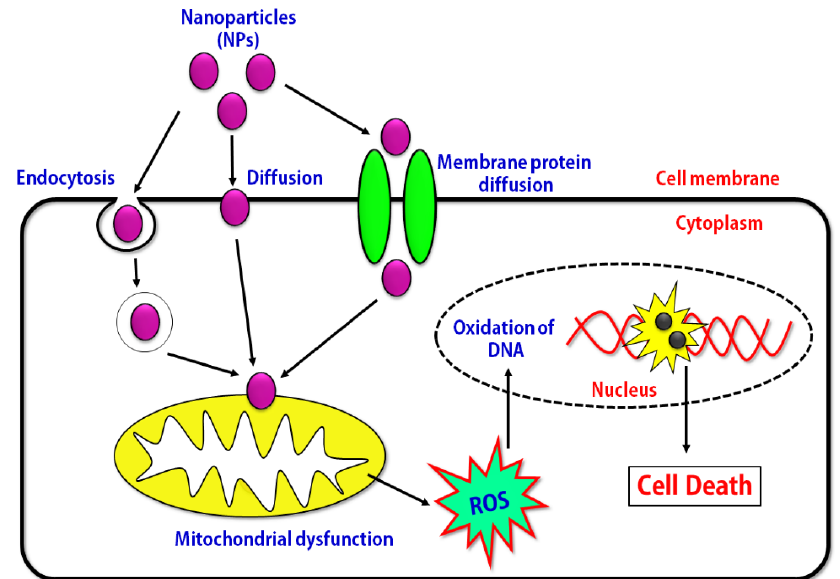
Figure 9. Theproposedcytotoxicmechanismof Pleurotussajor-caju medicatedbiosynthesizednanoparticles Figure 9. The proposed cytotoxic mechanism of Pleurotus sajor-caju medicated biosynthesized against colon cancer nanoparticles against colon cancer cells.